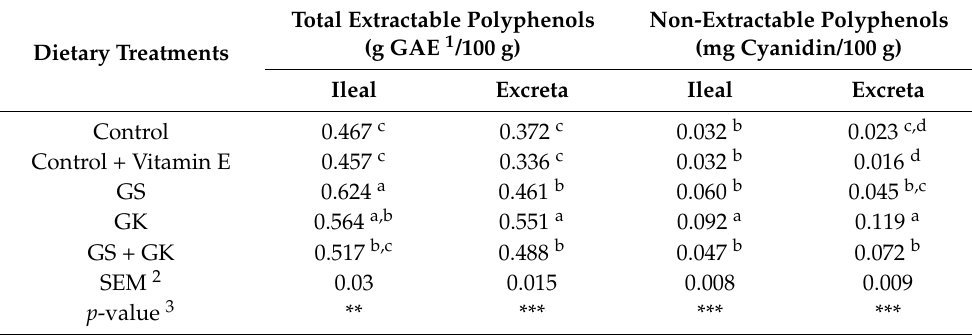
Table 5. Ileal and excreta total extractable and non-extractable polyphenol contents in broiler chickens